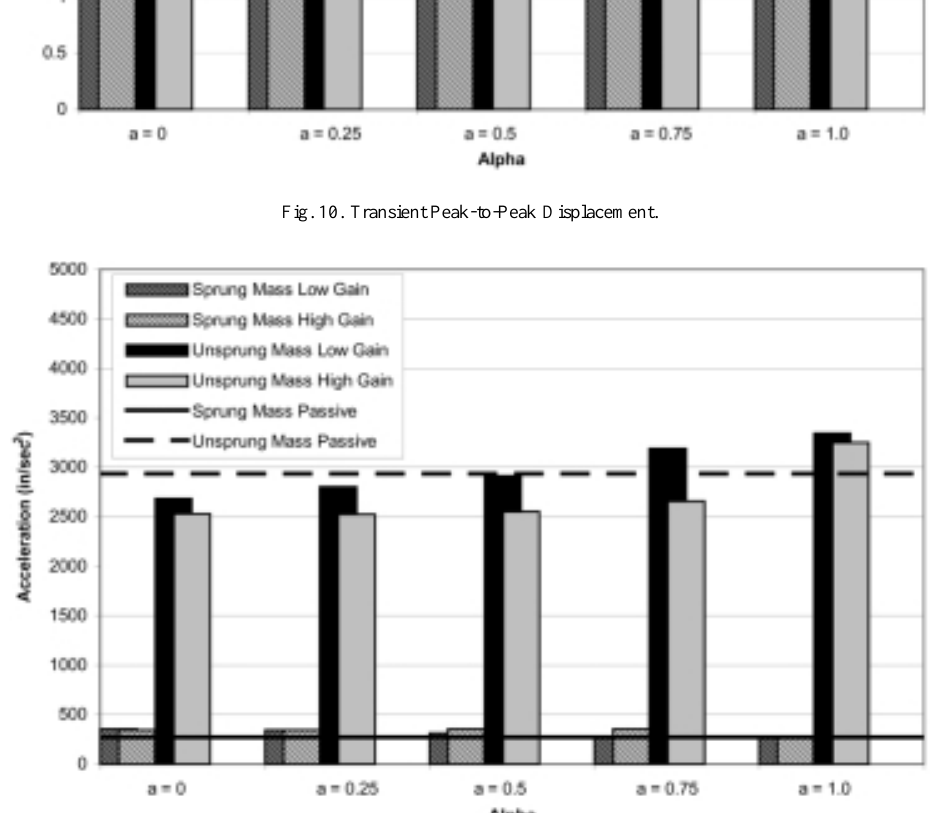
Fig. 11. Transient Peak-to-Peak